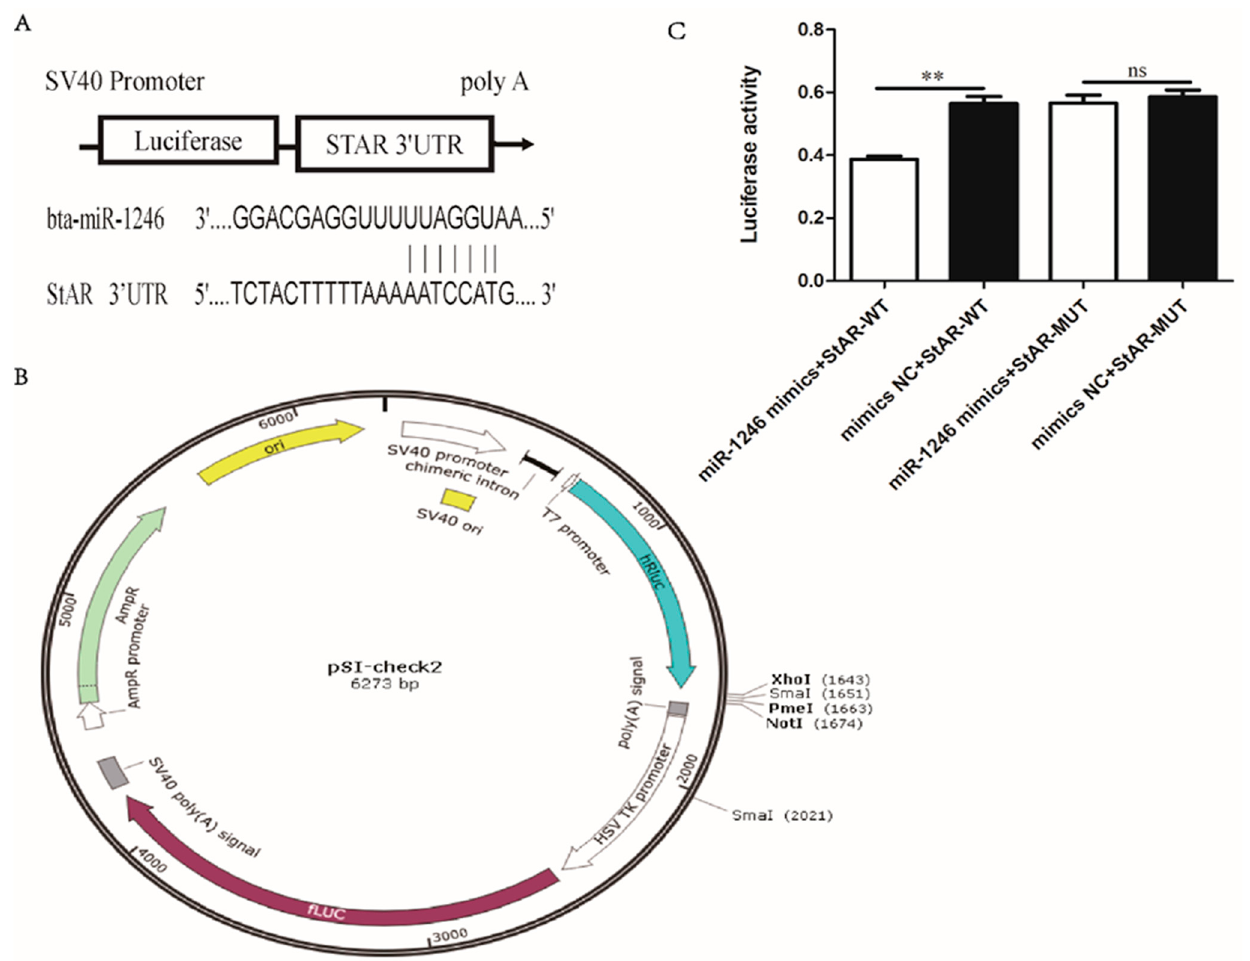
Figure 6. StAR was a target of miR-1246 in BGCs. ( A ) Predicted miR-1246 binding site in the StAR 3’UTR. ( B ) The luciferase reporter vector fused with StAR 3´UTR-WT or its MUT was constructed. ( C ) Dual-luciferase assay measuring the luciferase activity in different treatment groups of BGCs. Mimics NC, negative control of miR-1246 mimics; miR-1246 mimics, over- expression of miR-1246; WT, wild type; MUT, mutant. All data were presented as the mean ± SD ( n = 3), ** p < 0.01, ns means no